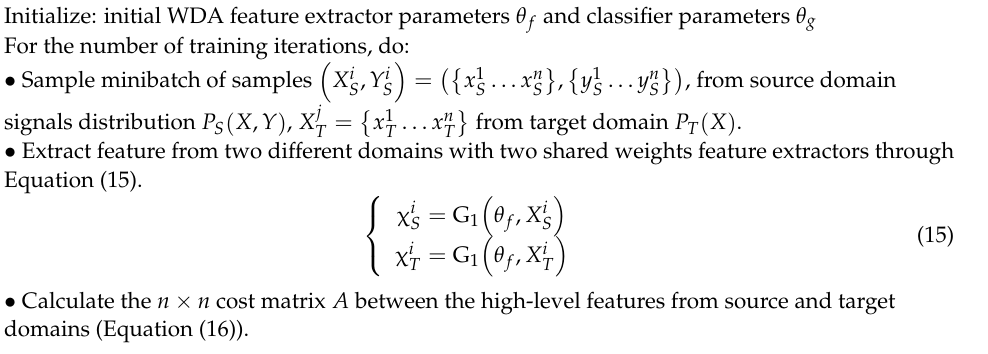
Algorithm 2. Training WDA with ADAM optimization method N c = number of